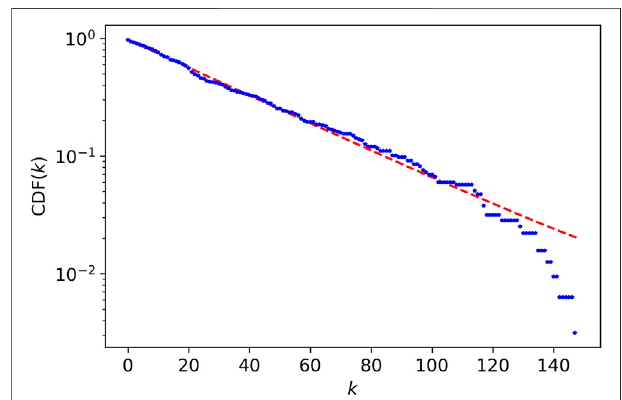
FIGURE 2 | Cumulative degree distribution of the co-investment